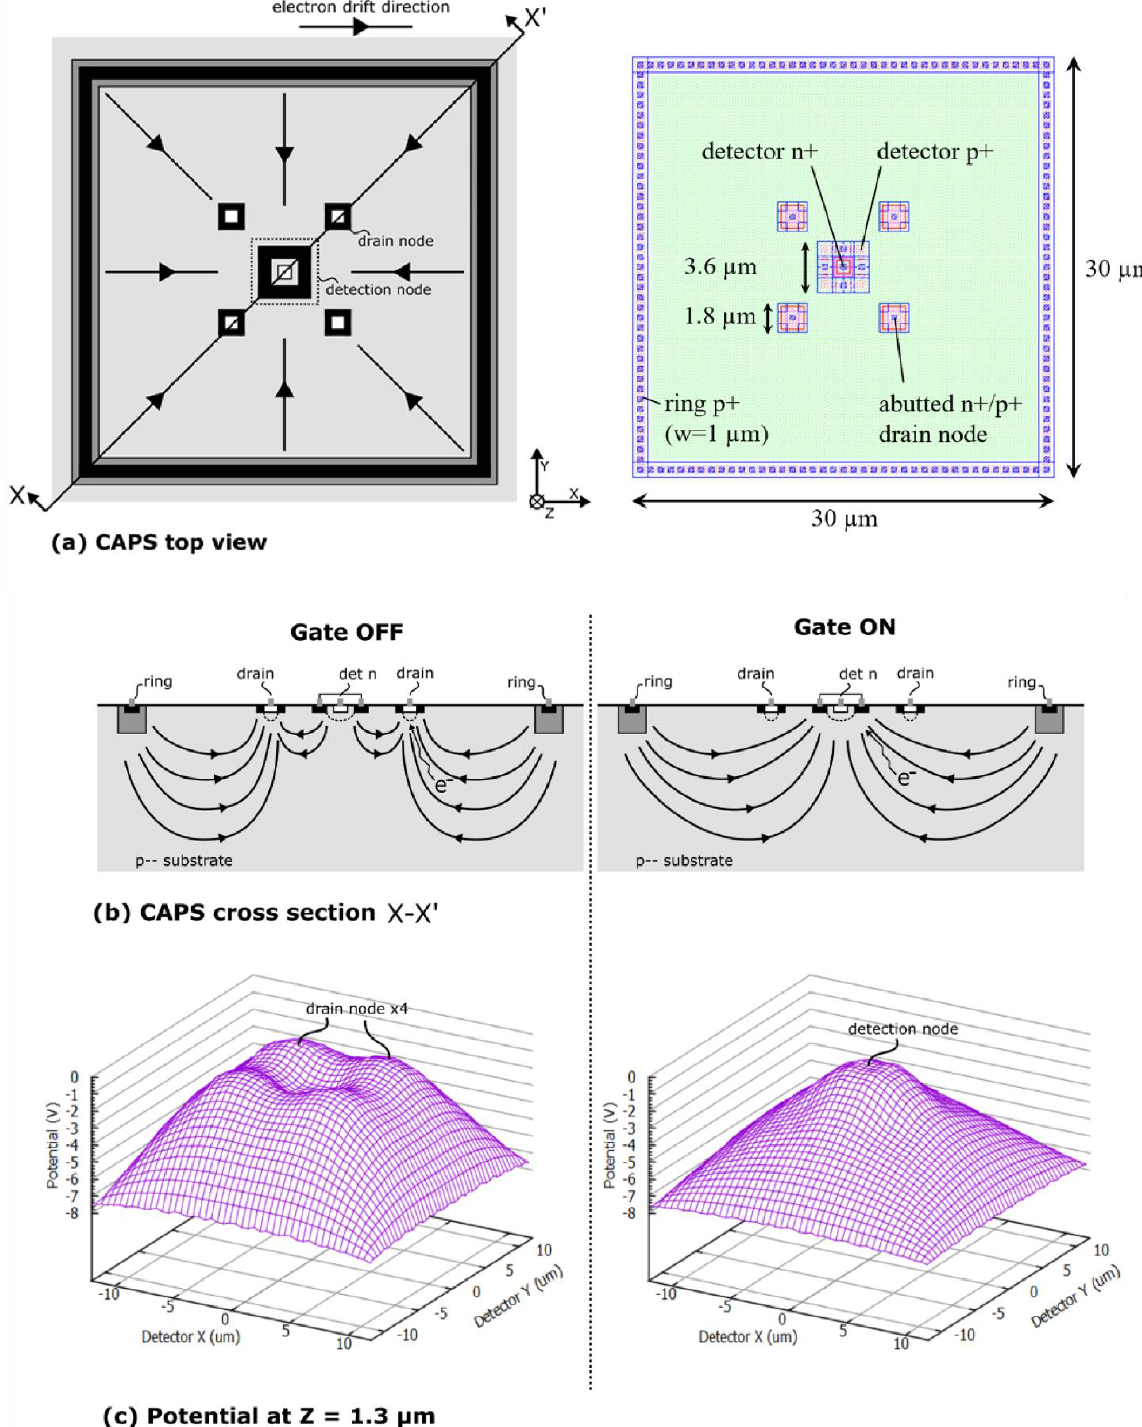
Figure 14. CAPS principle showing a top view of a CAPS sensor with detection node and four drain nodes with indication of drift field ( a , left) and top view of the layout with dimensions indicated ( a , right). CAPS cross section when the gate is OFF and when the gate is ON ( b ) and associated potential distributions at a depth of 1.3 µM ( c ).